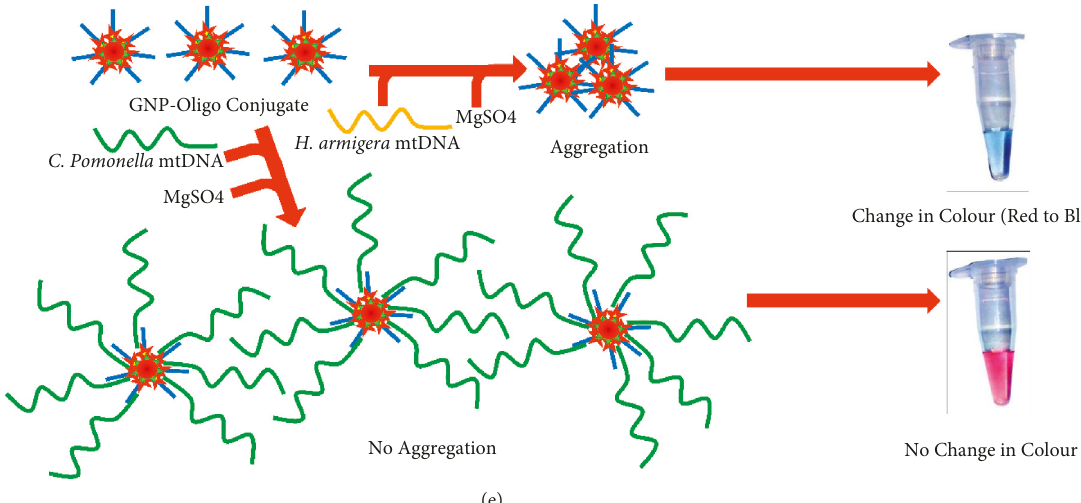
Figure 4: Hybridization of GNP-oligonucleotide conjugate with mitochondrial DNA. (a) Optimization of MgSO (b) Assessment of GNP-oligonucleotide conjugate sensitivity of GNP-oligonucleotide conjugate prepared using 1 μ M oligonucleotide probe. (c) Assessment of GNP-oligonucleotide conjugate sensitivity of GNP-oligonucleotide conjugate prepared using 0.5 μ M oligonucleotide probe. (d) Assessment of GNP-oligonucleotide conjugate specificity. (e) Graphical representation of the process of hybridization between GNP-oligonucleotide conjugate and mitochondrial DNA, and its outcome. NC, negative control without mtDNA; PS, sample containing Cydia pomonella mtDNA; CP, Cydia pomonella ; HA, Helicoverpa armigera ; (+), positive result; ( − ), negative